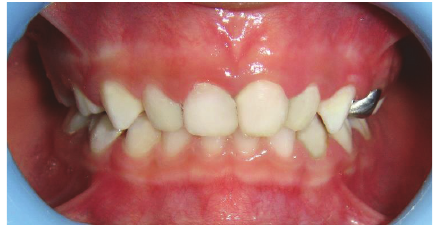
Figure 4: Preoperative photograph (Case 2 ).